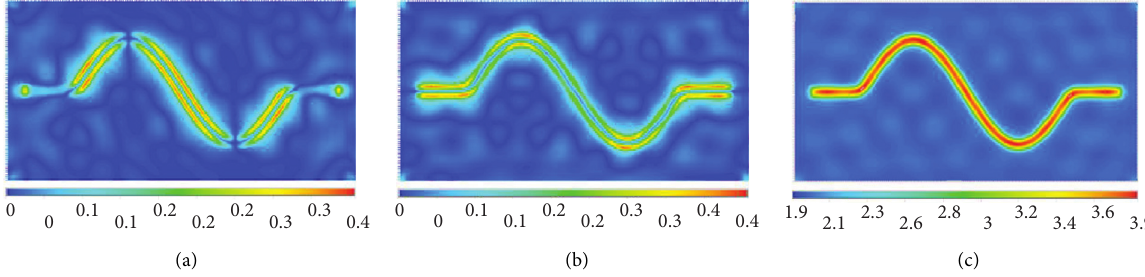
Figure 11: P wave incident ( f � 2.9Hz, H � 100m, C